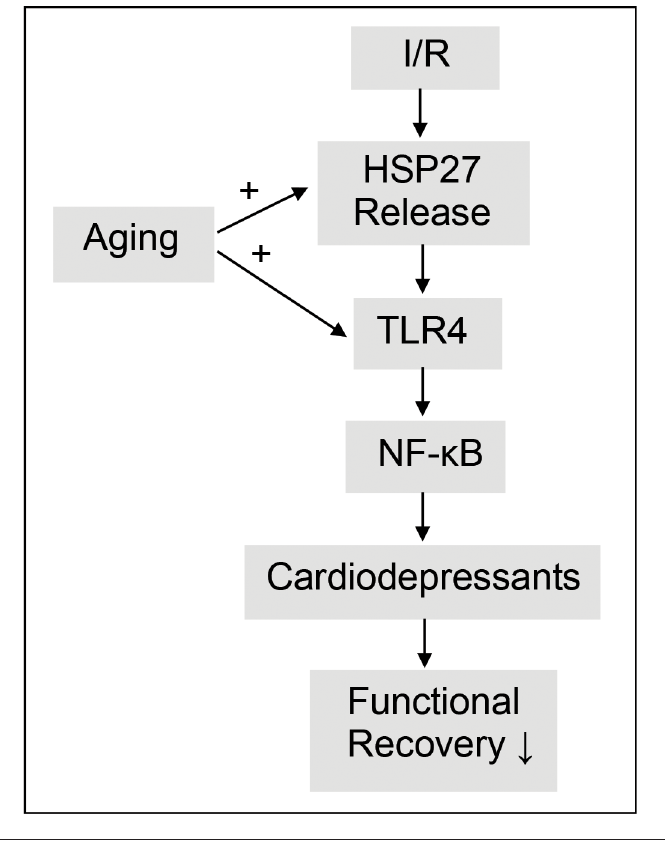
Figure 5. Schematic diagram depicting the mechanism underlying worsened recovery of cardiac function in aging hearts following global I/R. Myocardial I/R causes the release of HSP27, and extracellular HSP27 is one of the factors that activate myocardial TLR4. Aging exaggerates myocardial inflammatory responses to I/R through enhancing HSP27 release and elevating myocardial TLR4 levels, resulting in attenuated recovery of contractile